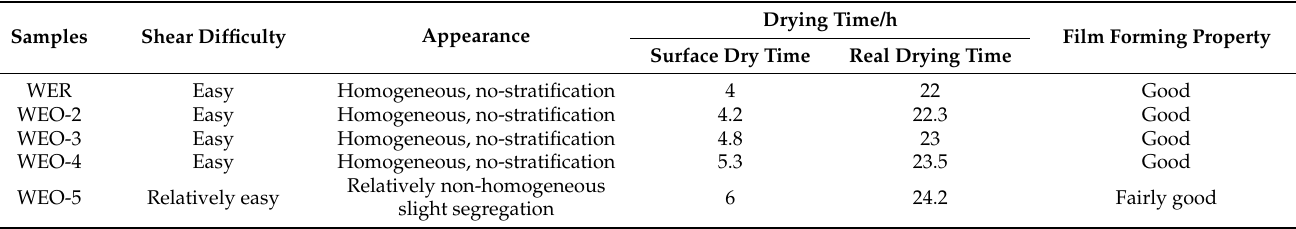
Table 3. Performance of WEO system with different contents of extraction